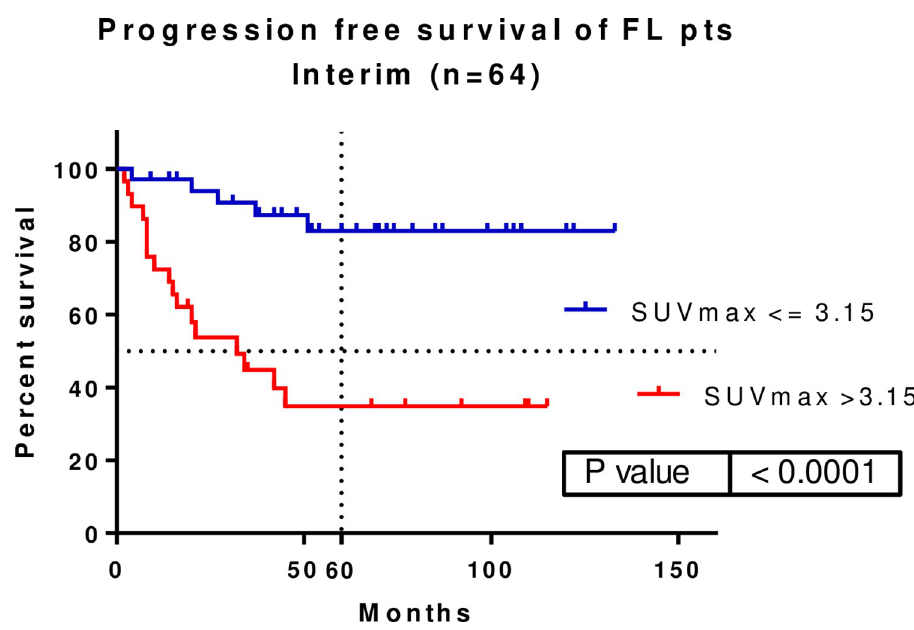
Fig 2. A significant progression-free survival (PFS) difference was shown with a SUVmax cut-off of 3.15 at the interim PET/CT (p < 0.0001, HR: 0.1614, 95%CI: 0.06684–0.3897). Five-year PFS was 82.94 vs. 34.86%. SUVmax– maximum of standardized uptake value.